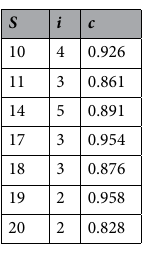
Table 2. All the eigenstates (cid:31) S , i of H (cid:31) with N = 8 and f = 3 having the